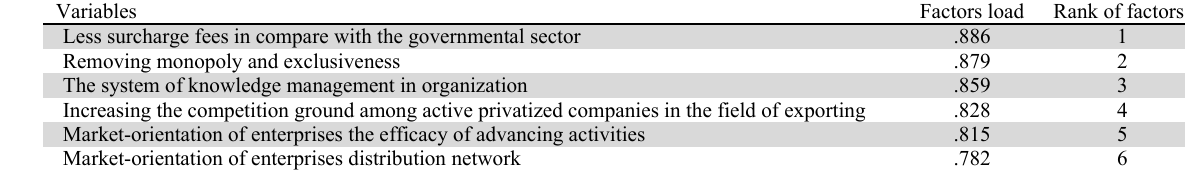
The summary of rationalism factors influencing on privatization Variables Factors load Less surcharge fees in compare with the governmental sector